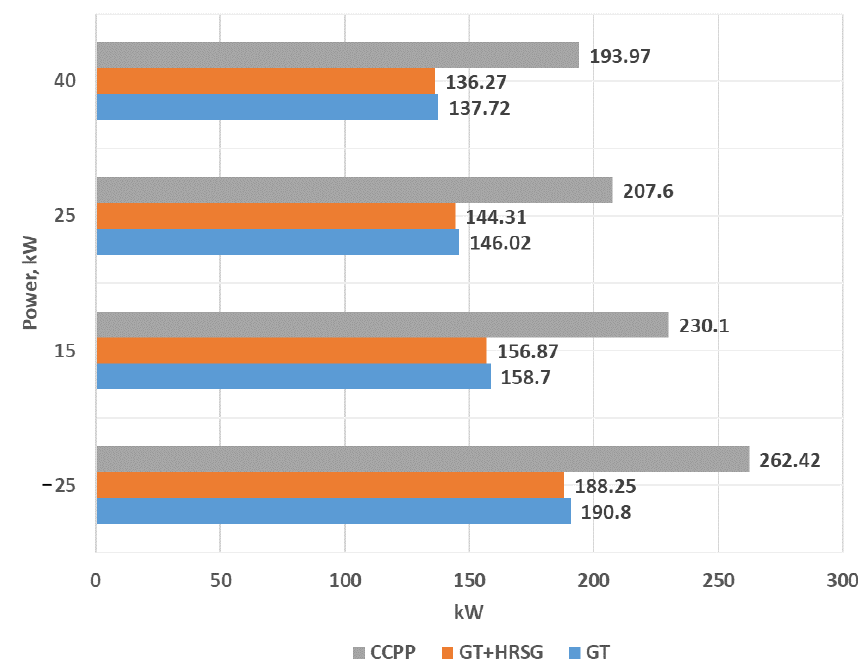
Figure 6. Dependence of power generation on ambient temperature.